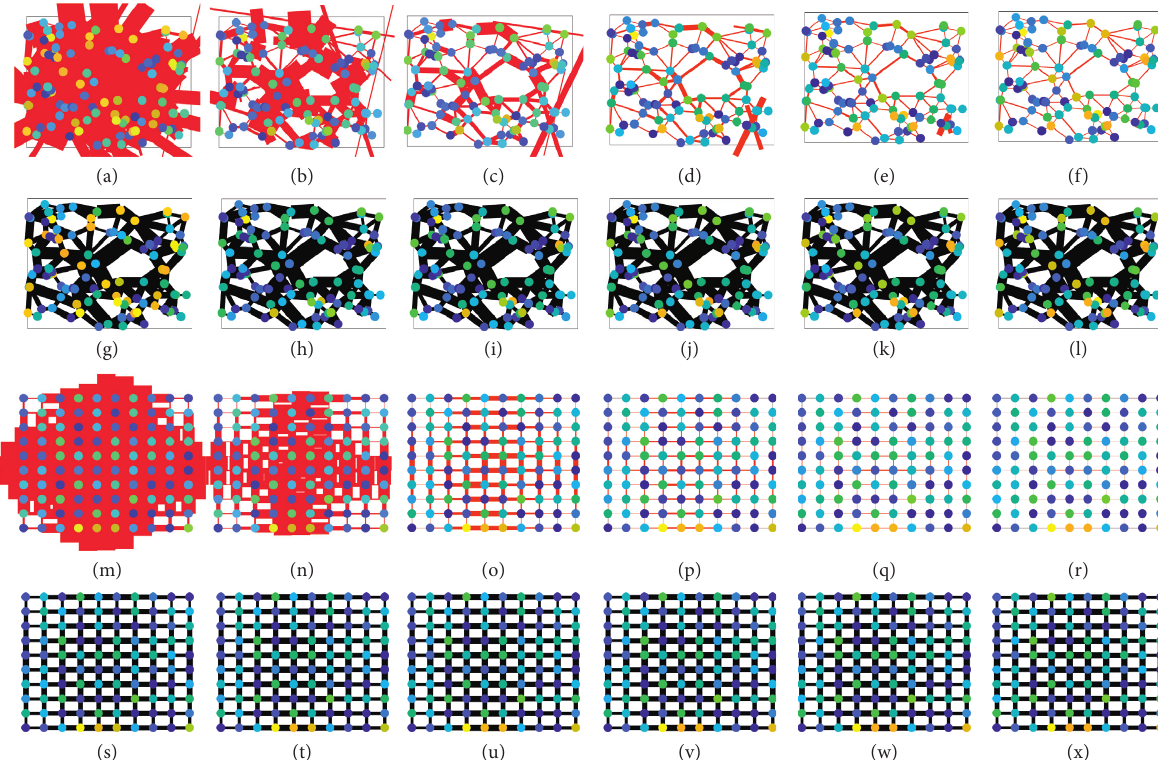
Figure 6: The optimisation of population distribution and travel times on the streets.